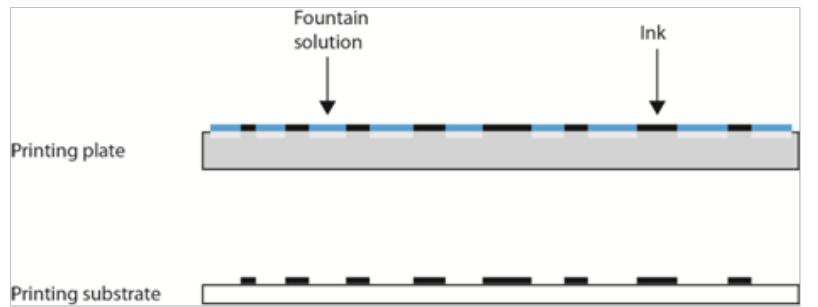
Figure 2. Offset printing plate after applying fountain solution and